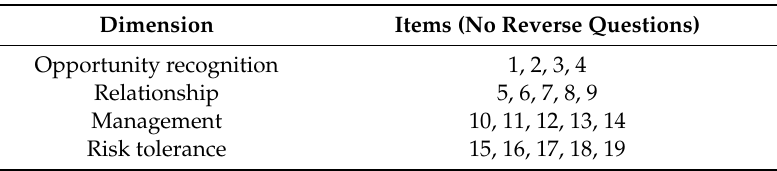
Table 1. Basic information of entrepreneurial self-e ffi cacy